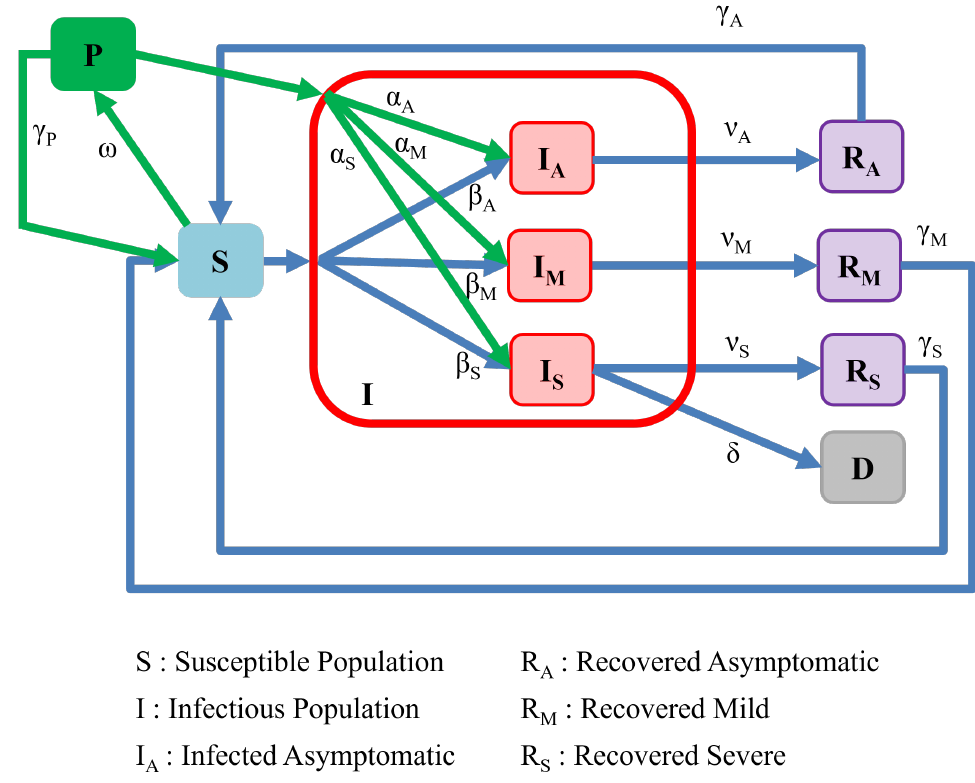
Figure 5. Compartmental model describing population interactions with different levels of disease severity and a vaccinated